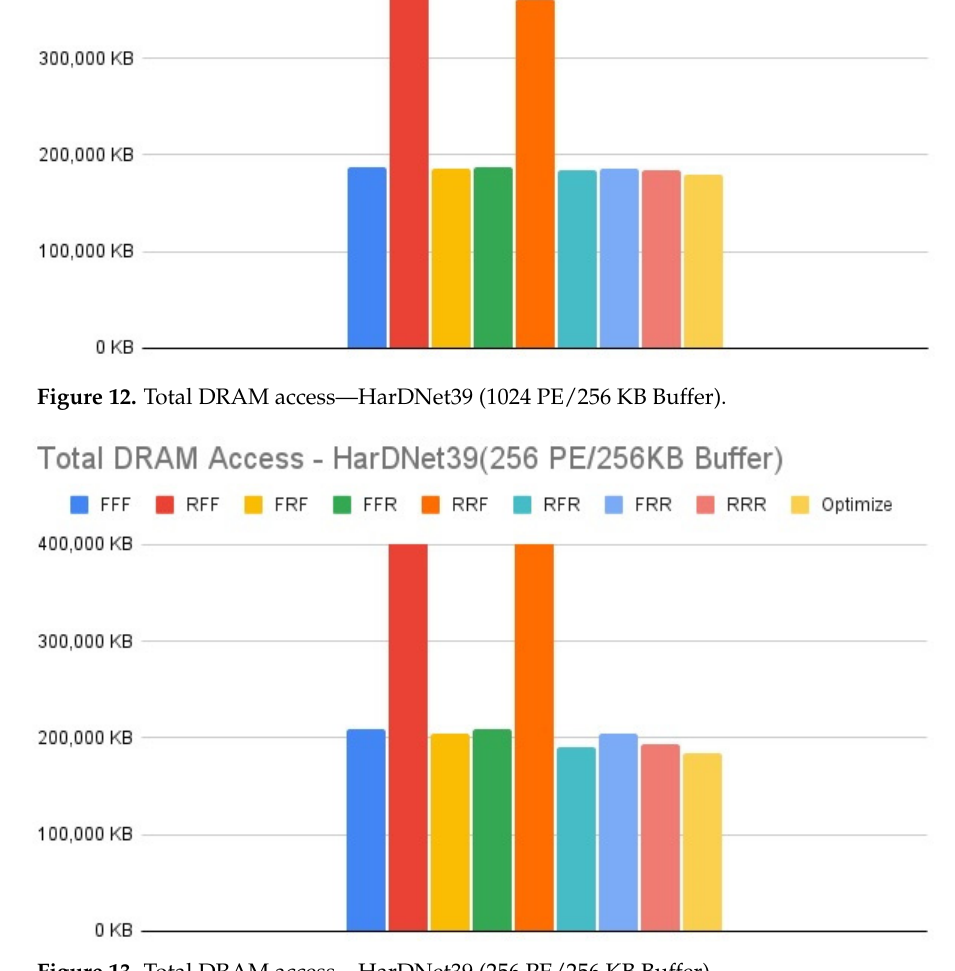
Figure 13. Total DRAM access—HarDNet39 (256 PE/256 KB Buffer).